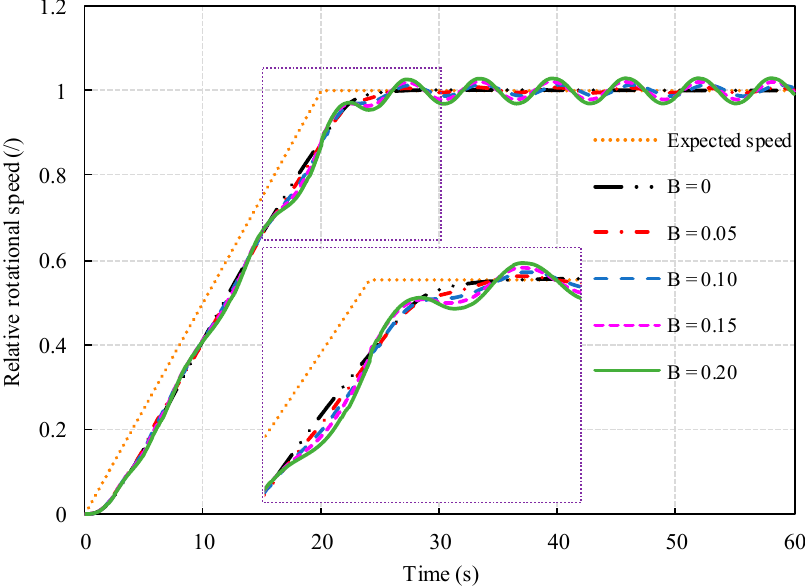
Figure 7. Comparison of closed-loop start-up speed characteristics of different tail water fluctuation amplitudes under a fixed frequency.